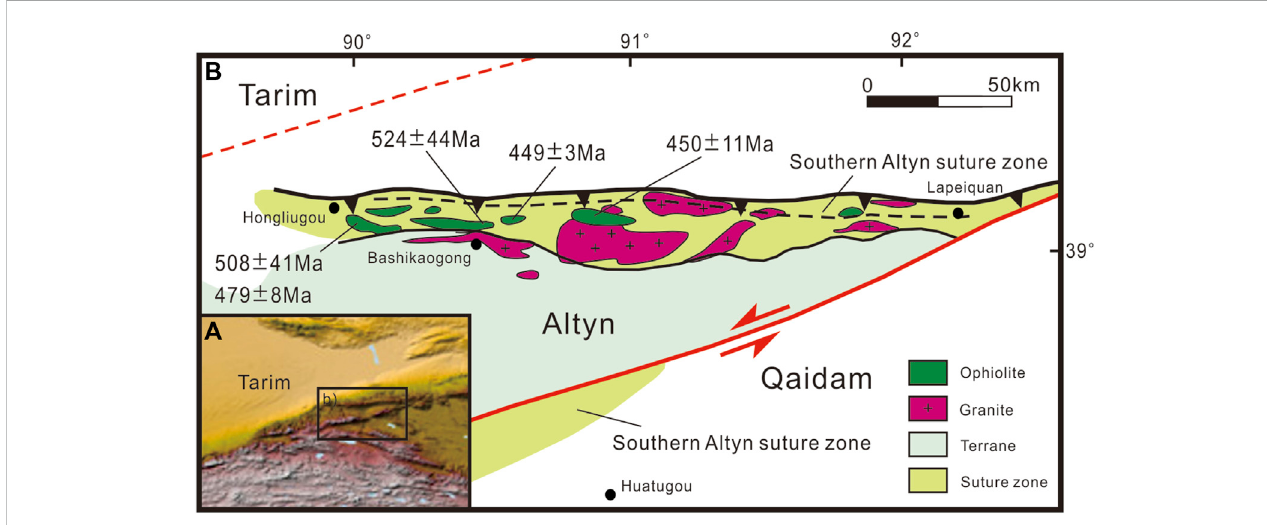
FIGURE 12 Location (A) and regional geological map (B) of Altyn Orogenic Belt and the age of the Northern Altyn ophiolite (modi fi ed after Mou et al., 2018, data comes from Che et al., 2002; Chen et al., 2017; Yang et al., 2008; Zhang et al., 2009; Yang et al., 2012).